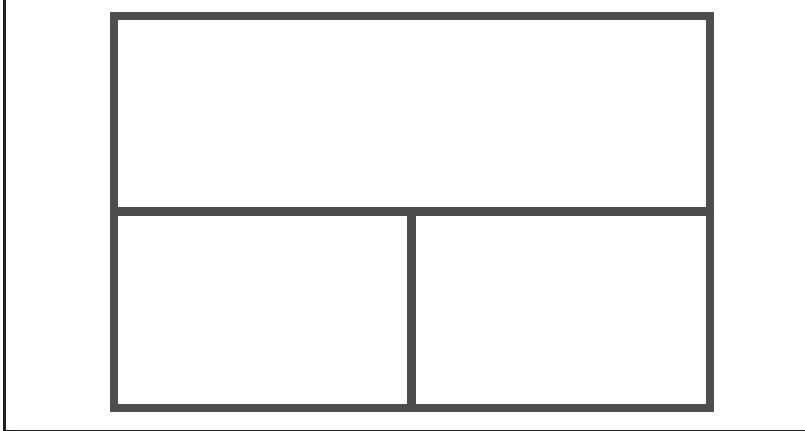
Figure 3: Part-part-whole worksheet Instruction: ‘Put 3 red counters in the bottom left field and 2 red counters in the bottom right block.